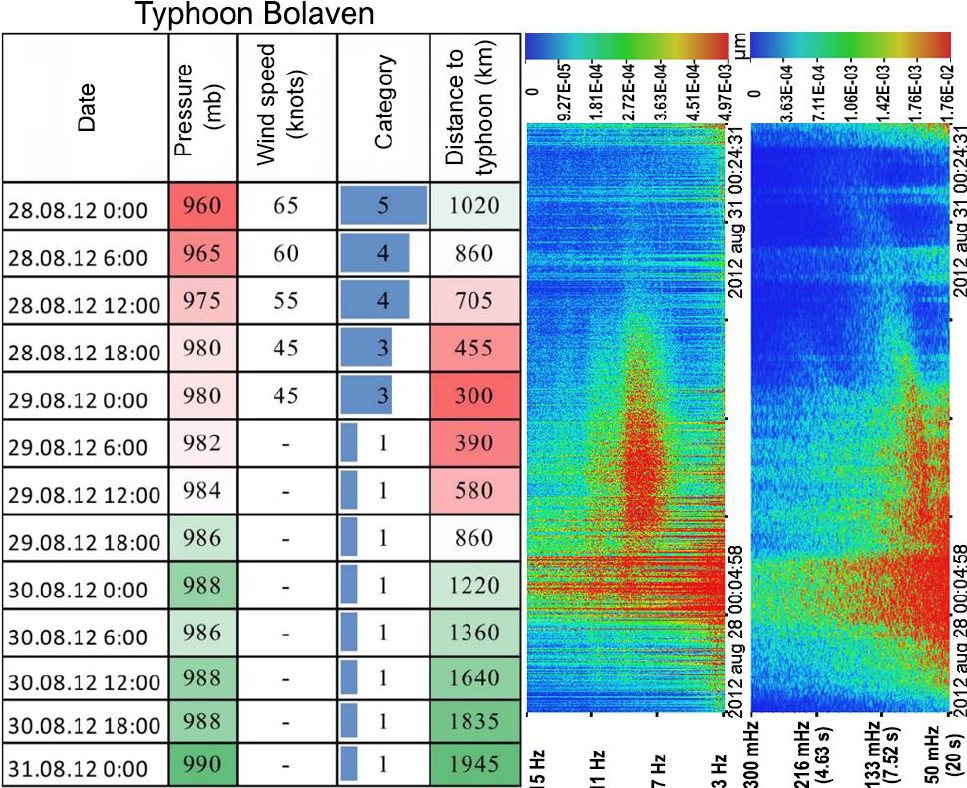
Figure 5. Typhoon Bolaven trajectory aligned with the images made by the “Himawari - 7” satellite in the infrared range. Red star – location of laser strainmeters.